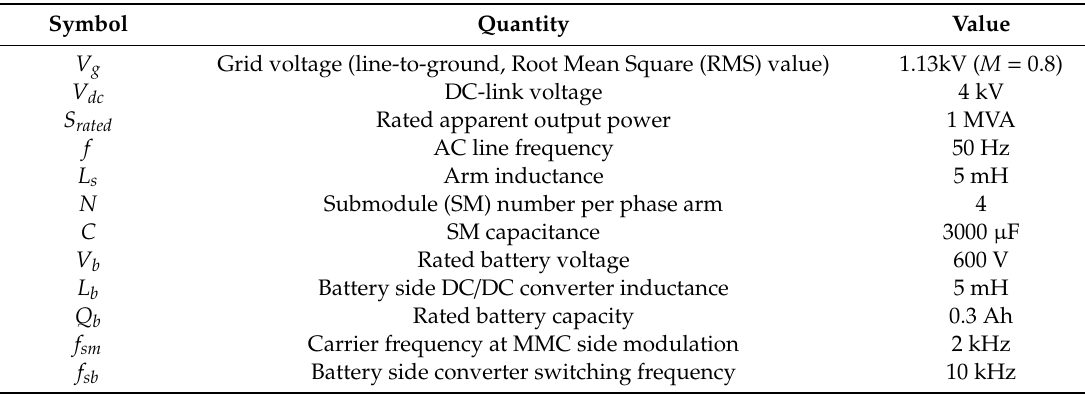
Table 1. Main parameters of the MMC-BESS simulation model.